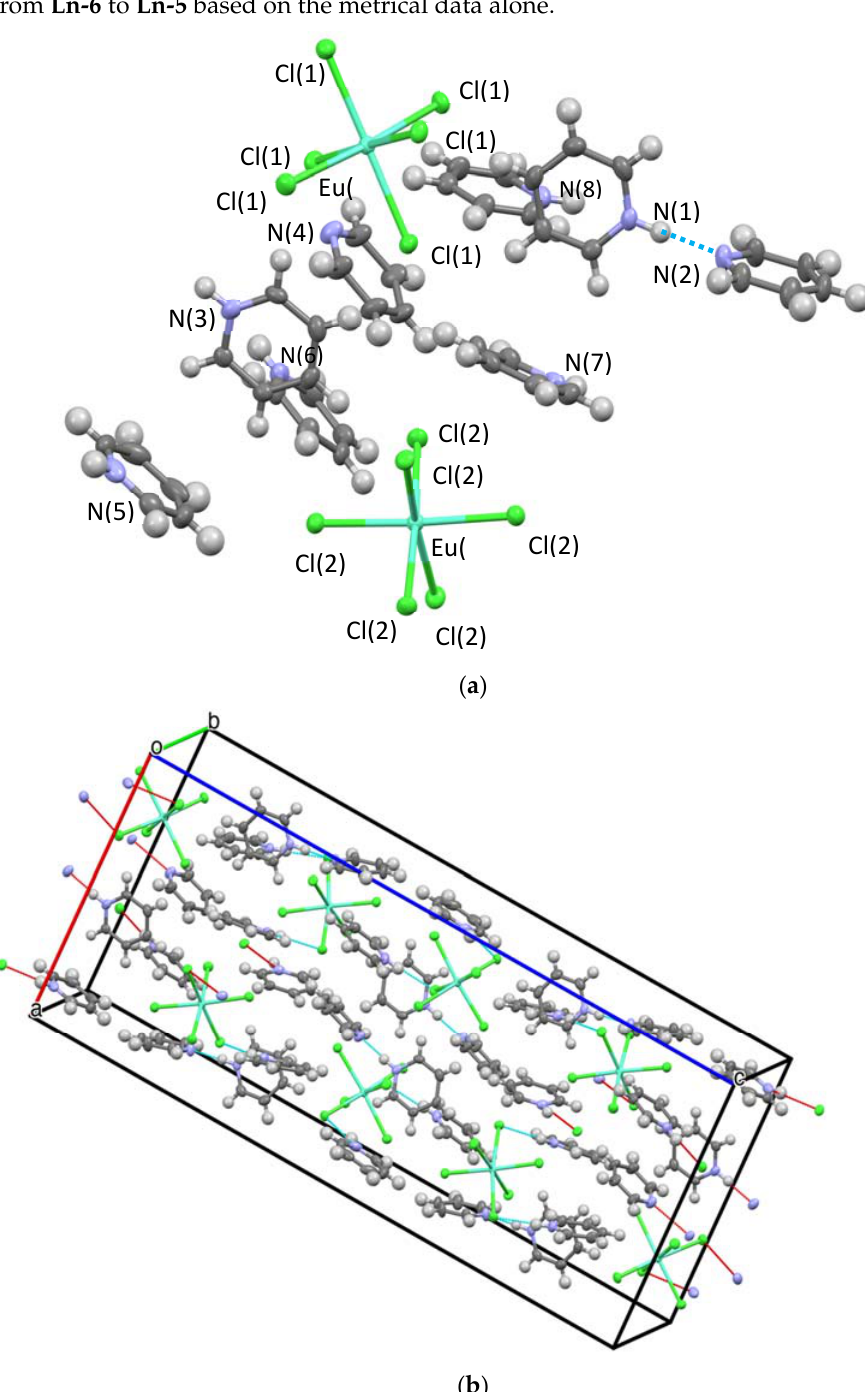
Figure 2. Structure plot of [[py-H-py][py-H] 2 [EuCl 6 ]] ( Eu-6 ) ( a ) unit cell solution and ( b ) packing diagram with H-bonding shown in blue dashes and short contacts in red. Thermal ellipsoids are drawn at 50% level.